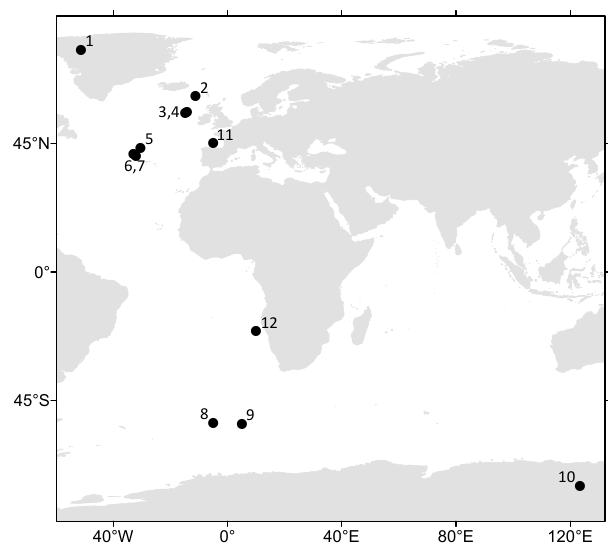
Figure 6. Location of the study sites, including marine and ice core sites. (1) NEEM, (2) ENAM33, (3) ODP980, (4) NA87-25, (5) SU90-08, (6) V30-97, (7) SU90-03, (8) PS2102-2, (9) OPD1094, (10) EDC, (11) MD04-2845. Site (12) corresponds to an unpub- lished marine core for which only the simulated temperature is available. Details about the cores and related proxy data are pro- vided in the text, in Table 2 as well as in Capron et al.